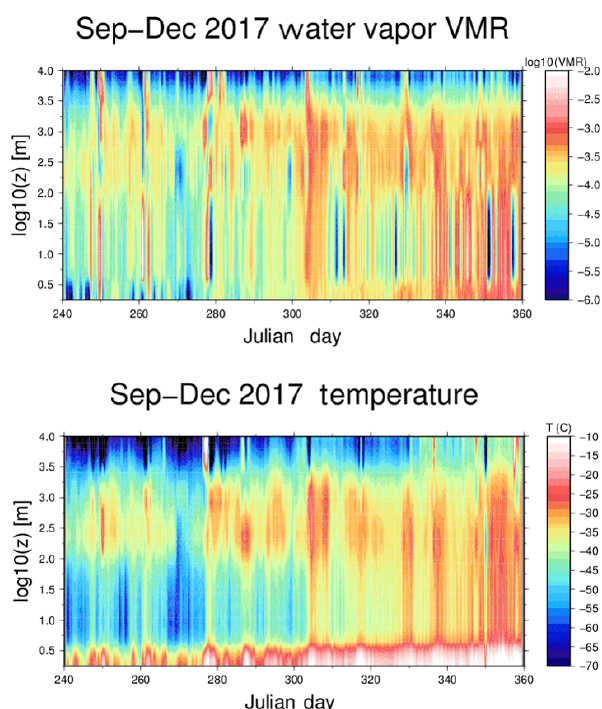
Figure 16. Vertical water vapor and temperature profile maps cov- ering the September–December 2017 period. The warmer layer in the first meters corresponds to the optical path inside of the shelter and of the measurement